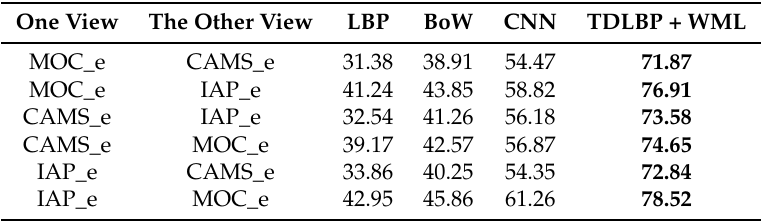
Table 7. Multi-view cloud recognition accuracies (%) comparing TDLBP + WML with three representative methods, i.e., LBP, BoW, and CNN.